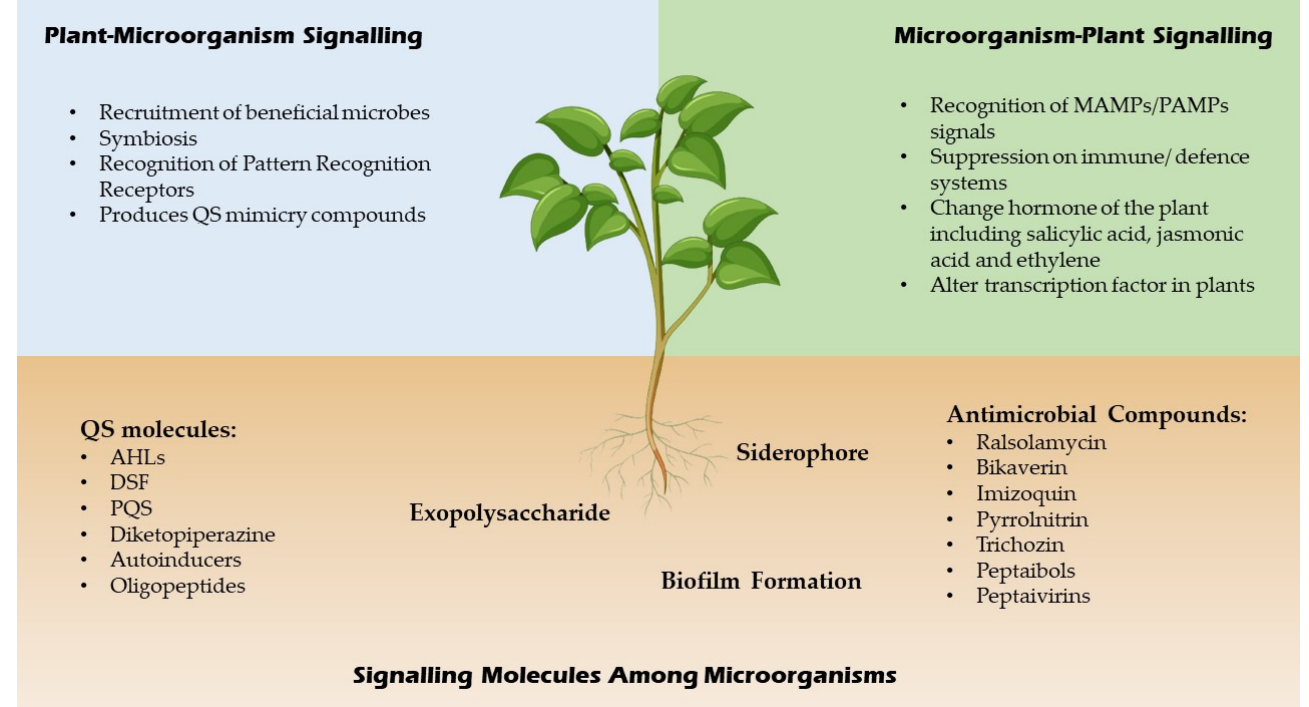
Figure 2. Signaling molecules of microbes and plants.